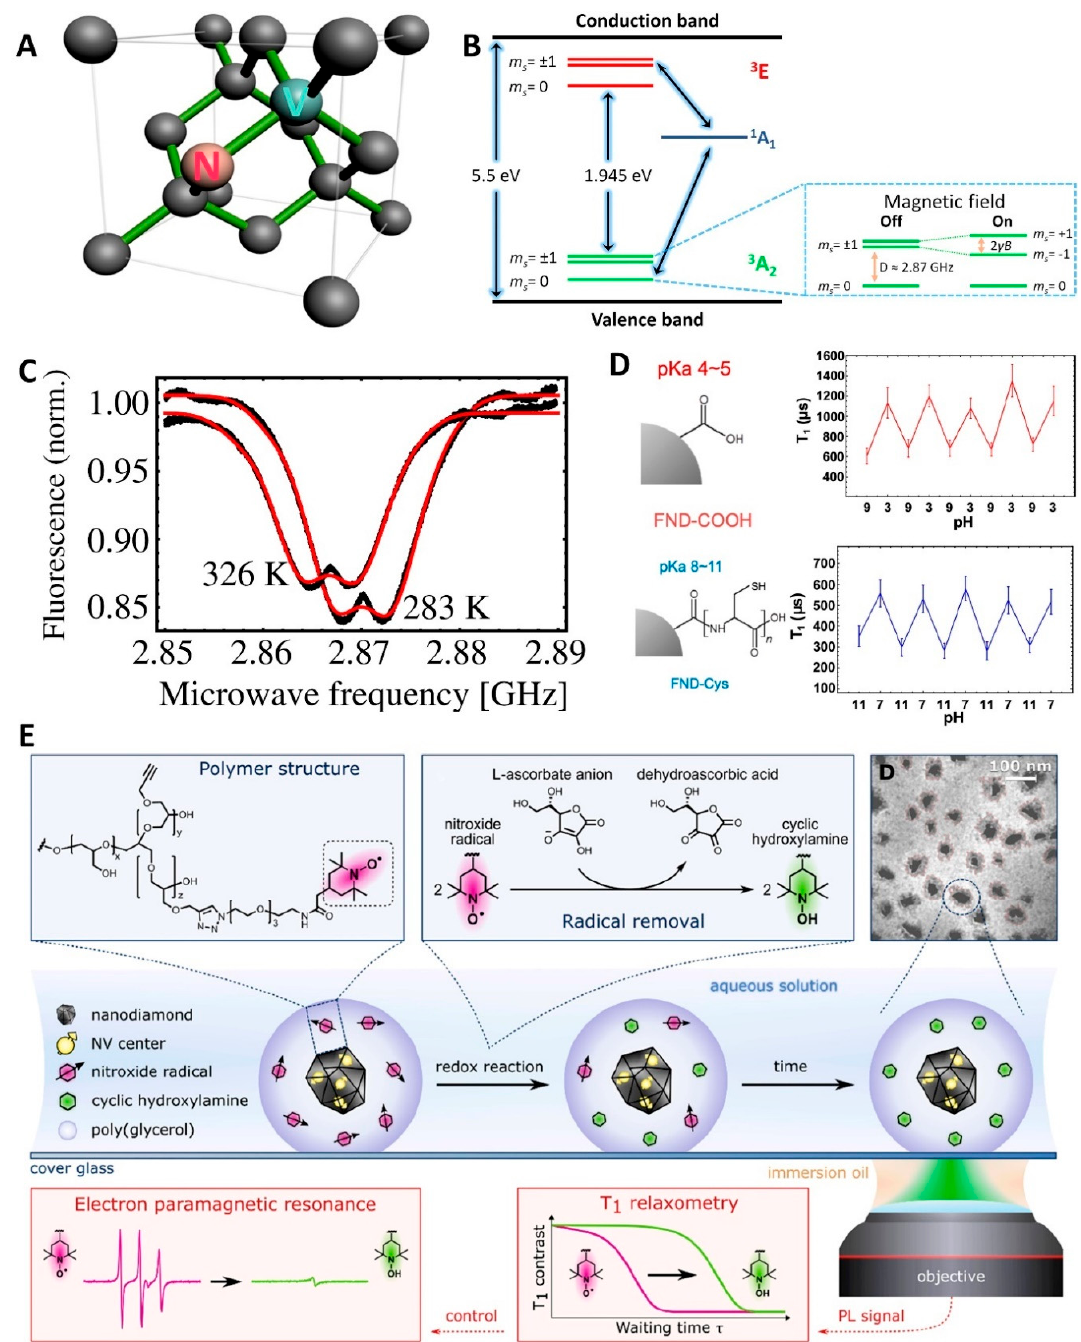
Figure 5. Characteristics of NV − centers and their sensing applications. ( A ) Crystallographic structure of an NV center in diamond, consisting of a substitutional nitrogen (orange) adjacent to a vacancy (green); ( B ) Energy-level diagram of an NV − center. A 1.945 eV spin conserving optical transition is required to excite the NV − from the ground-state ( 3 A 2 ) to the excited-state ( 3 E) triplets. Transitions from the m s = ± 1 sublevels of 3 E to an intermediate spin singlet ( 1 A 1 ), which decays to the m s = 0 ground state, are much stronger than those from the m s = 0 sublevel. The spin-selective nature of this decay path can be used in conjunction with the 1.945 eV transition to optically pump the system into the m s = 0 state. The expanded blue box shows the three spin sublevels with m s = 0 and m s = ± 1 in zero and nonzero magnetic fields, D is the zero-field splitting, and 2 γ B is the Zeeman splitting, where γ is the electron gyromagnetic ratio; ( C ) Thermal shifts of the spin resonance of NV − centers in FND at 283 and 326 K. The splitting observed in the ODMR spectra are due to crystal strain. Reproduced with permission from [18]; ( D ) The T 1 relaxation time can be modulated by changes in pH around the p K a of surface